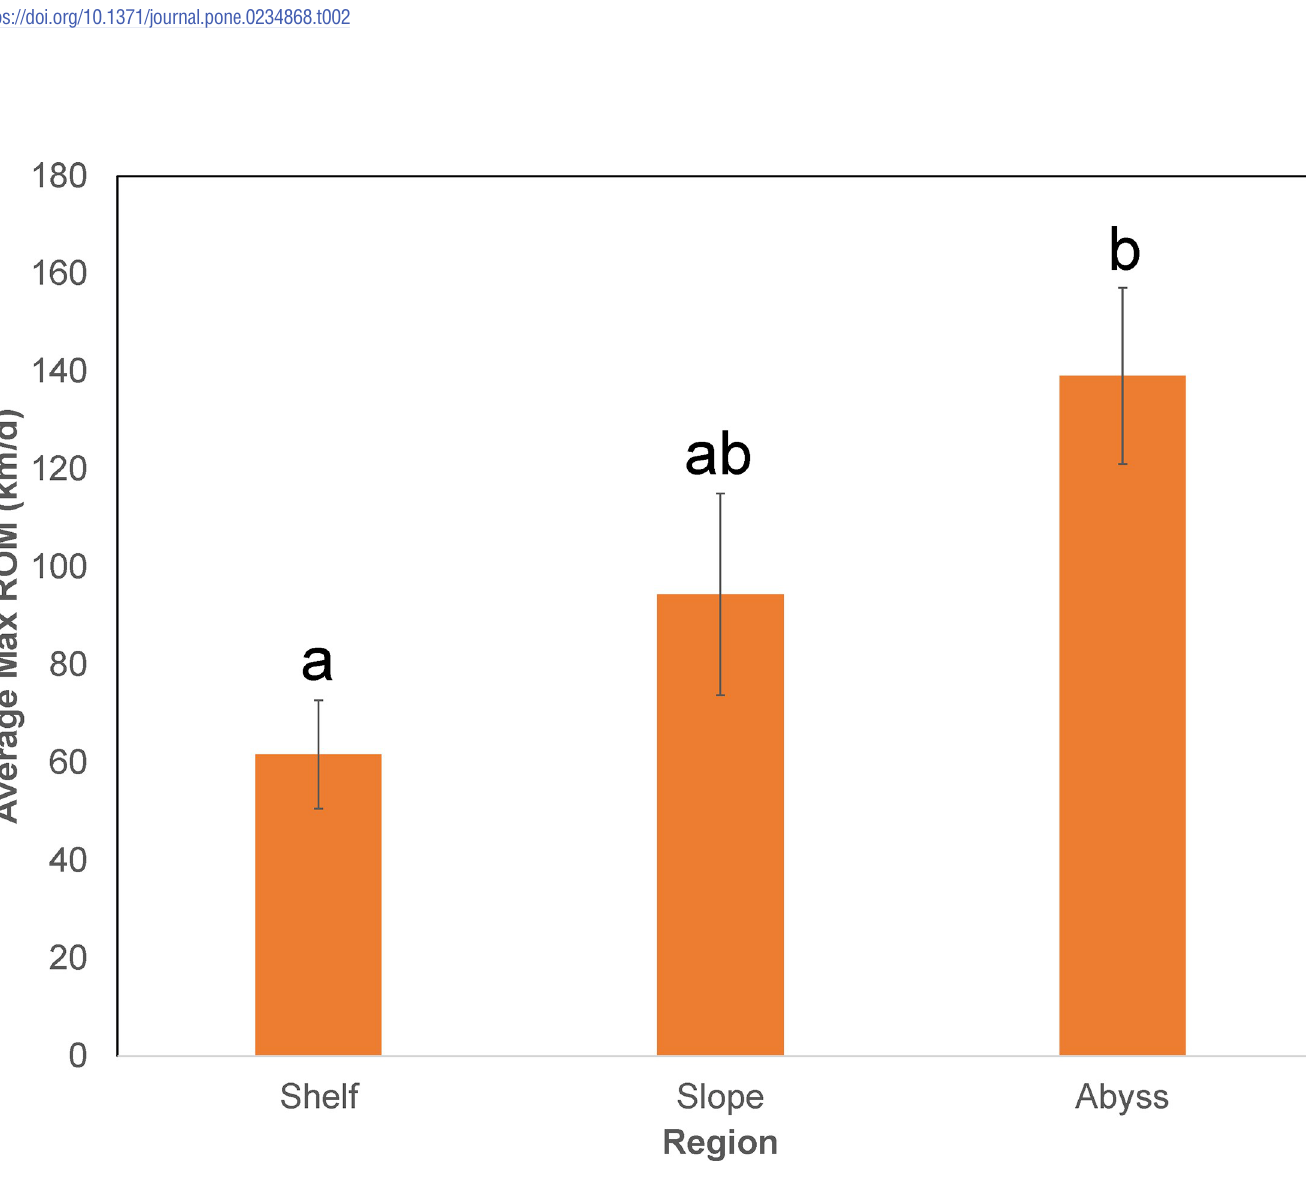
PLOS ONE | https://doi.org/10.1371/journal.pone.0234868 July 15,